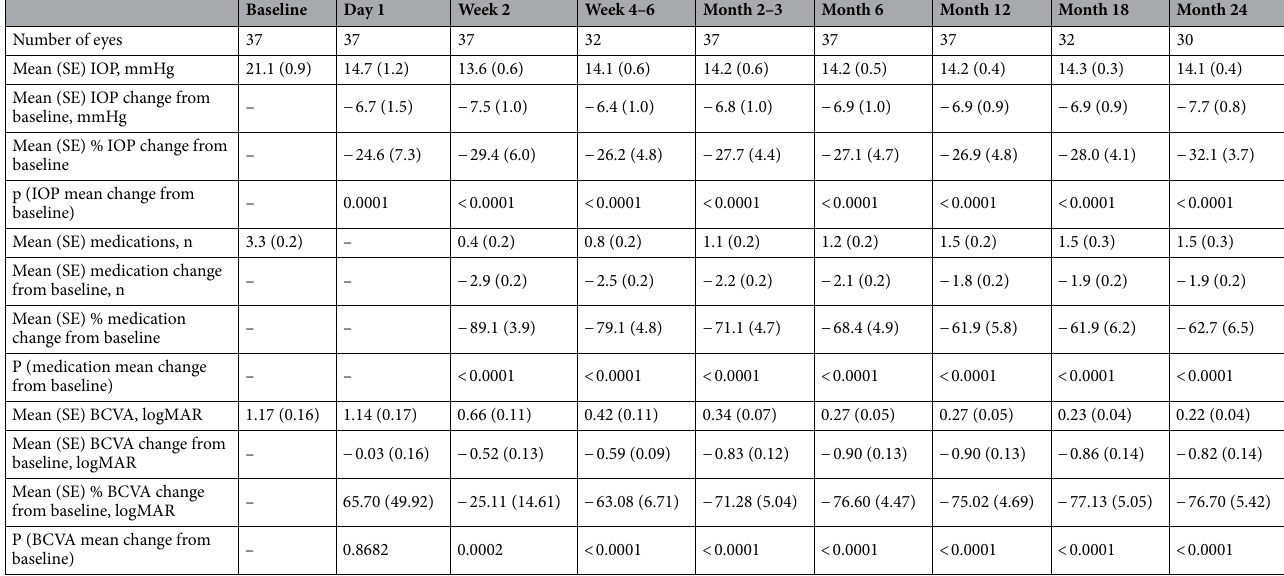
Table 2. Intraocular pressure, medication, and visual acuity data at each time point in eyes with open-angle glaucoma (n = 37). BCVA best-corrected visual acuity, IOP intraocular pressure, logMAR logarithm of the minimum angle of resolution, mmHg millimeters of mercury, SE standard